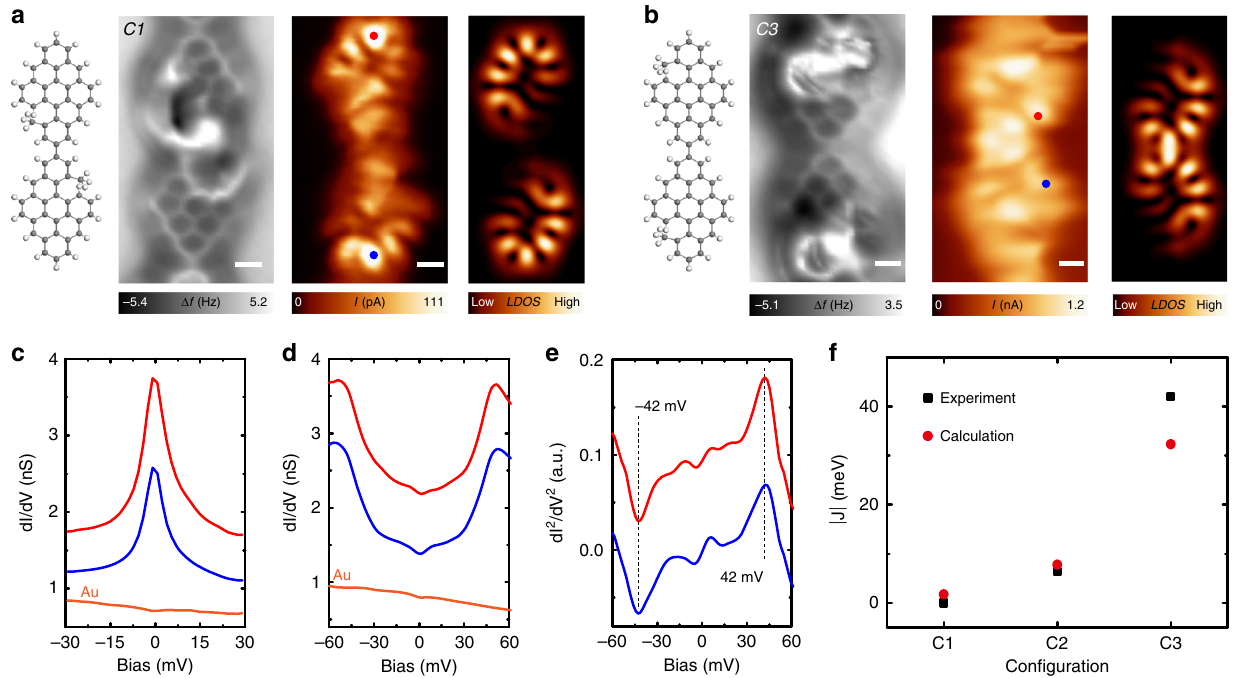
Fig. 4 Engineering exchange-interaction strength in diradical nanographene dimers. a From left to right: Chemical structure, nc-AFM image (Resonant frequency: 29 KHz, Oscillation amplitude: 160 pm), Constant-height current image (Bias voltage: 1 mV), and simulated LDOS map of a diradical nanographene dimer with minimum spin density overlap of the two spins. b From left to right: Chemical structure, nc-AFM image (Resonant frequency: 29 KHz, Oscillation amplitude: 160 pm), Constant-height current image (Bias voltage: 1 mV), and simulated LDOS map of a diradical nanographene dimer with maximum spin density overlap of the two spins. c d I /d V spectra spectra taken on the two locations marked in a . The presence of Kondo resonances at each unit in the dimer suggest a negligible exchange interaction. d – e d I /d V spectra and numerical calculated d I 2 /d V 2 spectra taken on the two locations marked in b . Two symmetric peaks have been detected, suggesting an antiferromagnetic coupled ground state with exchange-interaction strength of 42 meV. f Summarized exchange-interaction strength of three dimer con fi gurations C1 – C3 marked in Figs. 3 and 4. Scale bars: 0.3 nm.